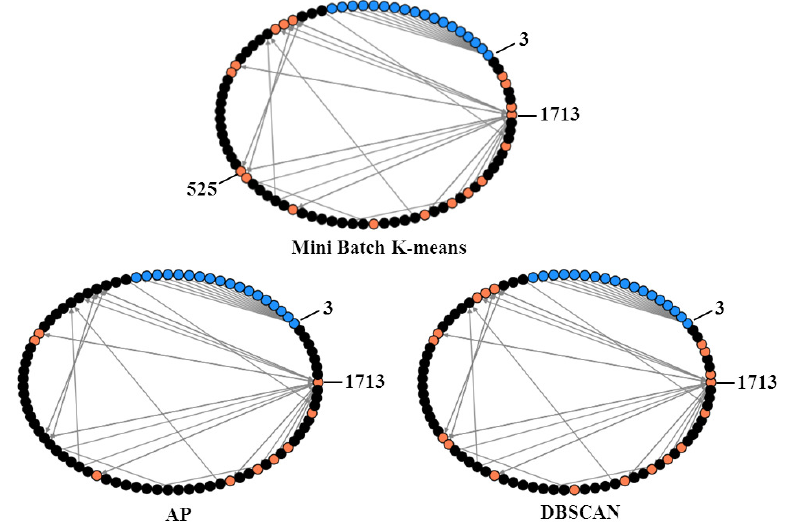
Figure 6. Results of community detection with AP, Mini Batch K-means, and DBSCAN. The blue nodes and node 3 are in the same community. The orange nodes belong to community of node 1713. The division is only different in a few